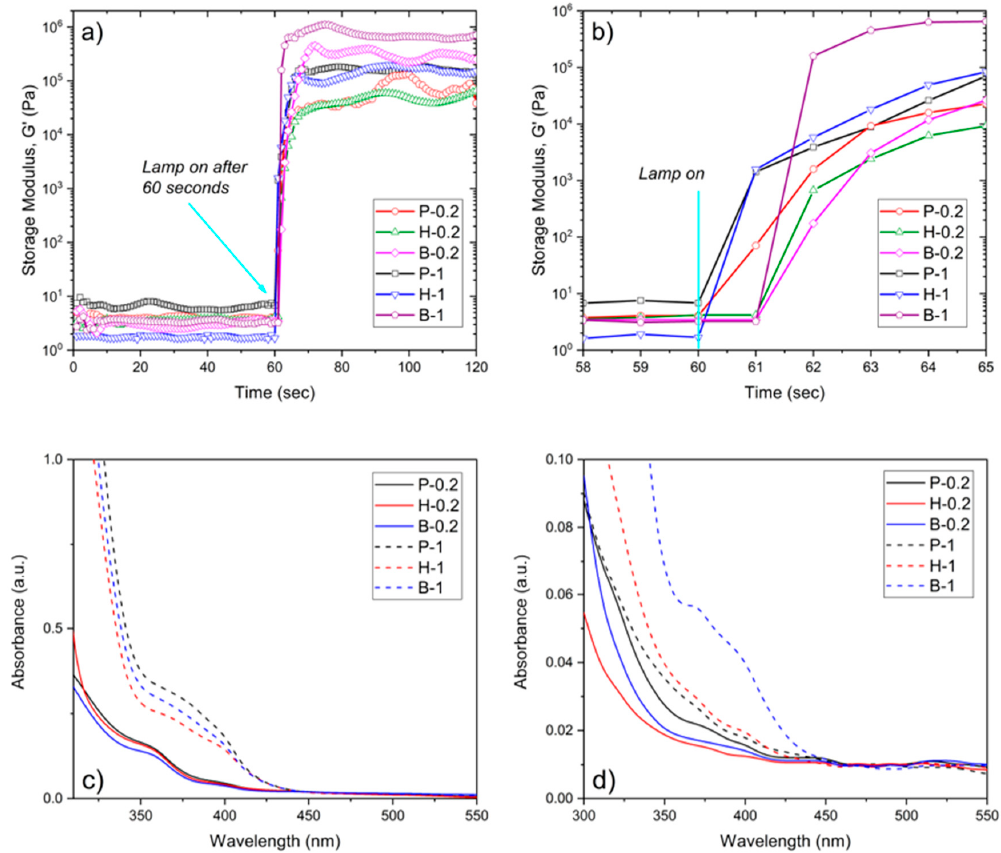
Figure 1. ( a ) Storage modulus (G’) as a function of irradiation time (Intensity 20 mW / cm 2 ) for PEGDA, BEDA, and HDDA formulations containing 0.2 and 1 wt.% of BAPO. ( b ) Zoom of the G’ vs. irradiation time after the visible lamp is on. ( c ) UV-vis spectra of 100 µ m thick 3D printed discs made of PEGDA, BEDA, and HDDA formulations with 0.2 wt.% (continue lines) and 1 wt.% (dashed line) of BAPO. ( d ) UV-Vis spectra of the extracting solvent used for the calculation of the insoluble gel fraction of the 3D printed